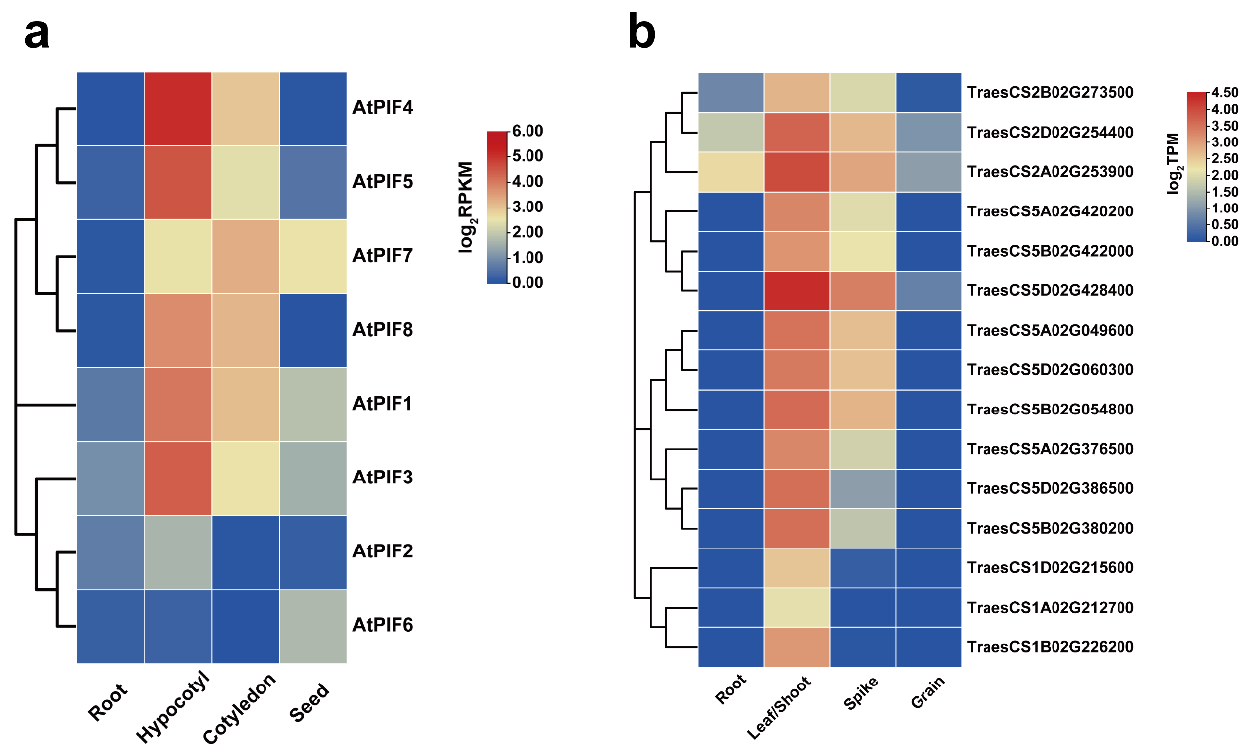
Figure 3. Expression analysis of PIFs in different Arabidopsis and Triticum tissues. ( a ) Hierarchical clustering of expression profiles of AtPIF genes in different tissues. The RPKM values of each gene are normalized by log2. ( b ) Hierarchical clustering of the expression profiles of TaPIF genes in different tissues. The TPM values of each gene are normalized by log2.